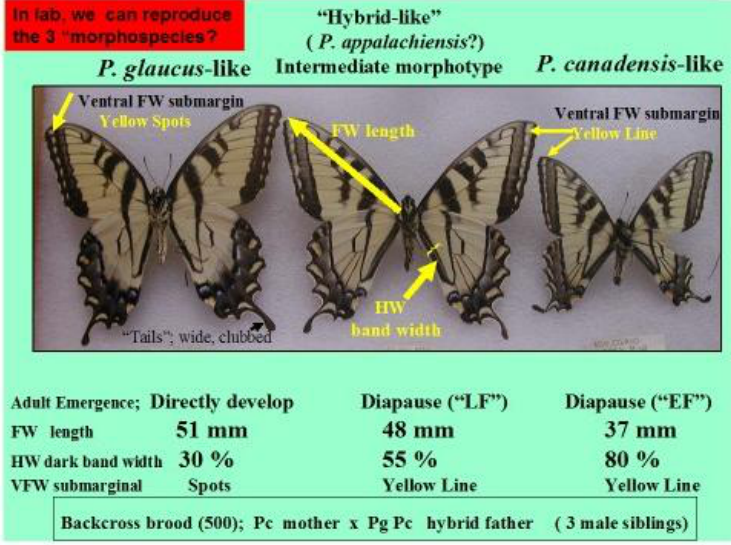
Figure 11. The basic morphospecies of P . glaucus (multivoltine), P . appalachiensis (univoltine delayed emergence), and P . canadensis (inivoltine) showing species-diagnostic traits (FW length, HW band width, and ventral submarginal spots/band [99,330]). These 3 individual phenotypes are genetically distinct siblings that were produced by hand-pairings in the lab (a backcross of a P . canadensis mother with a hybrid male). In addition to morphometric segregation with diapause regulation [481] (Figure 12), additional backcrosses of hybrid P . glaucus and P . canadensis to a parental species also resulted in high levels of recombination [10] and recombinant genetic segregation of key Z (=X)-linked ecological traits [24,482].